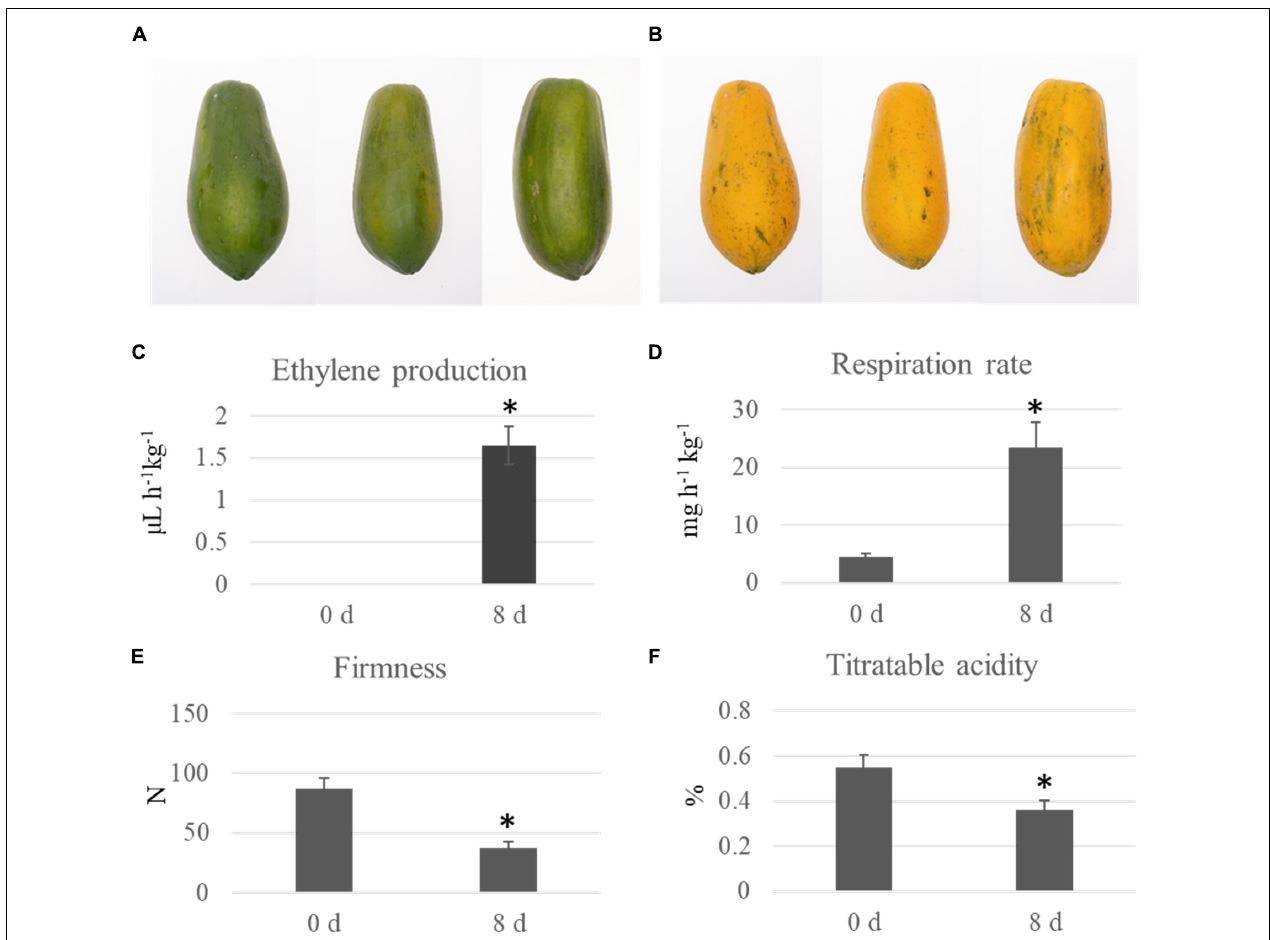
FIGURE 1 | Physiological changes of papaya fruit at time point 0 and 8 d. The picture of papaya fruit at 0 (A) and 8 d (B) . Four physiological parameters, including ethylene production (C) , respiration rate (D) , firmness (E) , and titratable acidity (F) , of papaya fruit at two time points after harvest were analyzed. Significant differences in physiological parameters between time point 0 and 8 d were indicated by